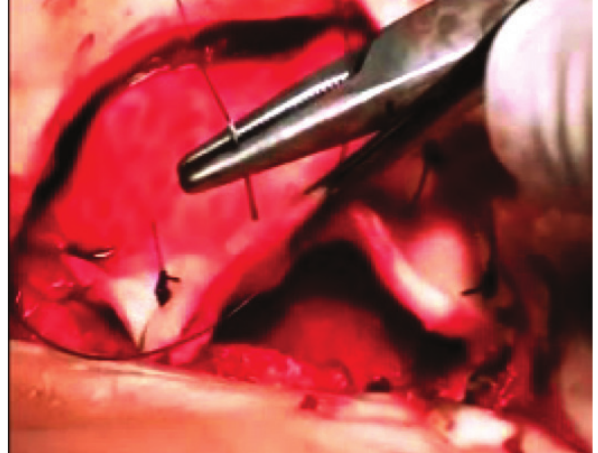
Figure 4: Extracellular matrix fixed in double layers at the medial margins of the bilateral ribs with multiple intermittent not absorba- ble suture during surgical reconstruction of chest defect.